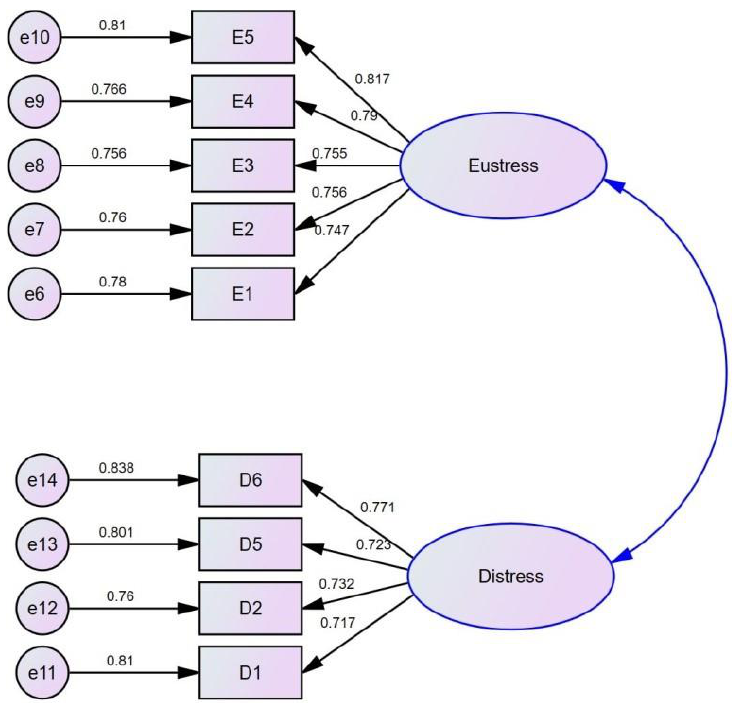
Figure 2. Confirmatory factor analysis, e6 to e14 are error terms, E1 to E5 are items of Eustress, and D1, D2, D5, and D6 are items of Distress, and Arrows are representing factor loadings. Literature suggests that the AVE of all the variables should be bigger than maximum shared the square variance (MSV) and average shared square variance (ASV) [29], which can be seen in our case (see Table 5). The correlation of each construct was less than the square root of AVE. The goodness of model fit can be seen in Table 6, which presents the goodness of fit of the five variables.